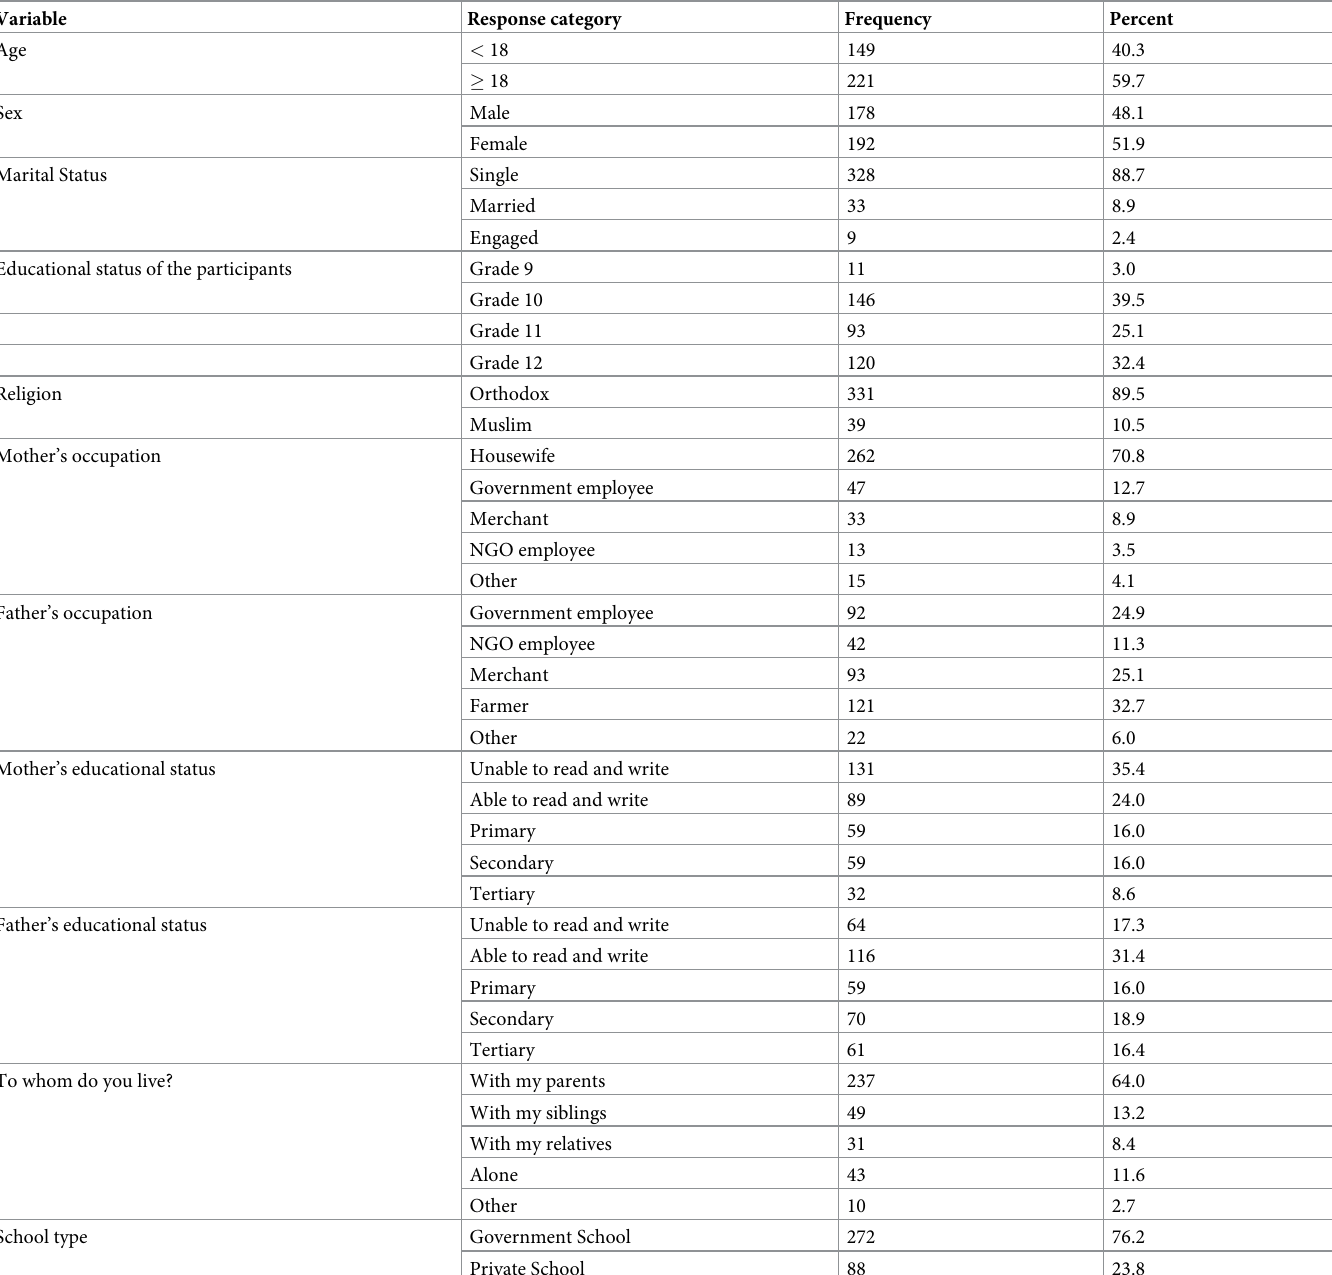
Table 1. Socio-demographic characteristics of Gondar city secondary school students, North West Ethiopia, 2020 (n = 370).